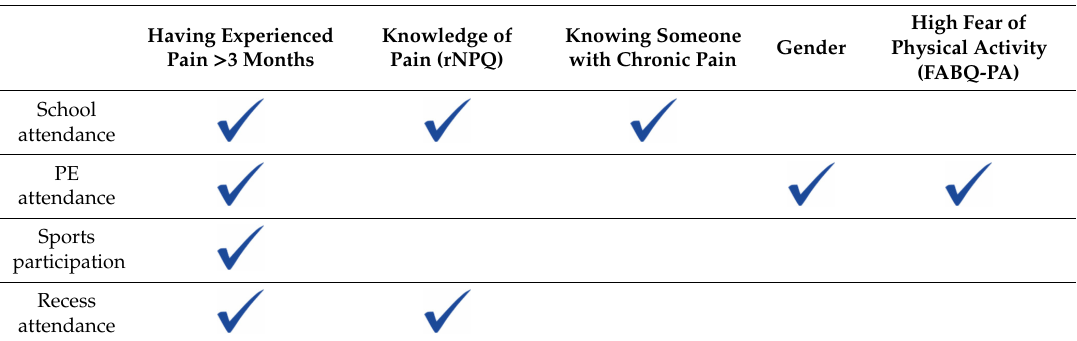
Table 5. Factor predictive of school attendance, physical education (PE) attendance, recess attendance and sports participation 6 months